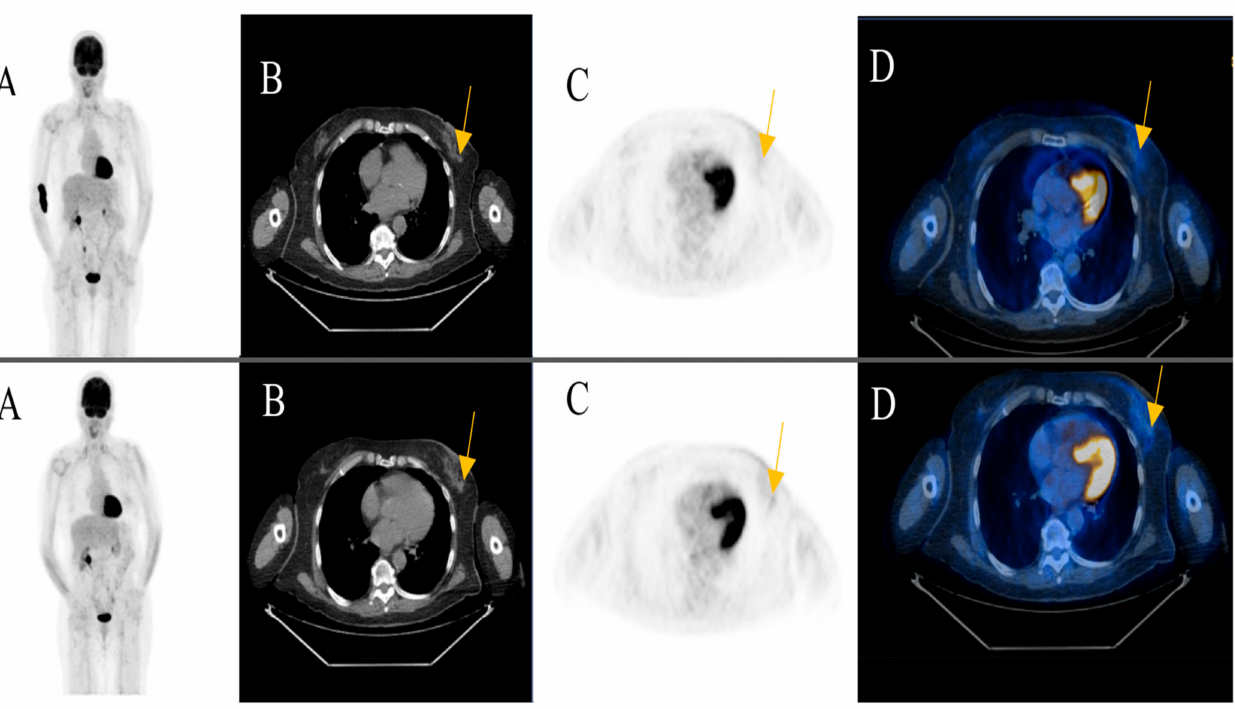
Figure 3. An 81-year-old female patient initially with metastatic cutaneous melanoma stage IV (pT2a N3 M1b). ( A ) Maximum intensity projection (MIP); ( B ) Computed Tomography (CT) axial of chest; ( C ) Positron Emission Tomogra- phy( PET) axial of chest; ( D ) Fused images PET/CT axial of chest. First row: FDG-PET/CT performed for surveillance after treatment without evidence of metabolically active recurrence, nodal or distant metastasis. Contamination at injection site cubital on the right upper extremity. Second row: Six months later, a morphologic and metabolic progredient subcutaneous nodule in the left breast was seen (yellow arrow). An ultrasound-guided biopsy was subsequently recommended for further evaluation. The biopsy revealed an invasive ductal breast